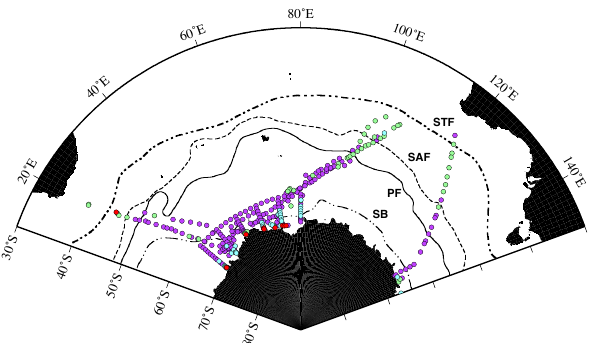
Fig. A3. Distributions of the four cluster groups. Circles in red, green, blue, and purple represent cluster group A, B, C and D, re-